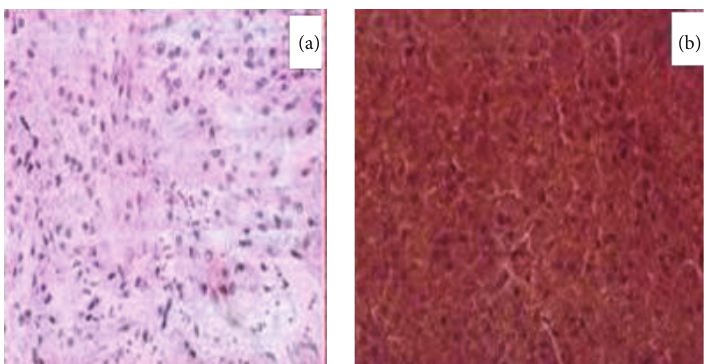
Figure 4: Immunochemistry results showing presence of S-100 (a) and chromogranin markers (b).